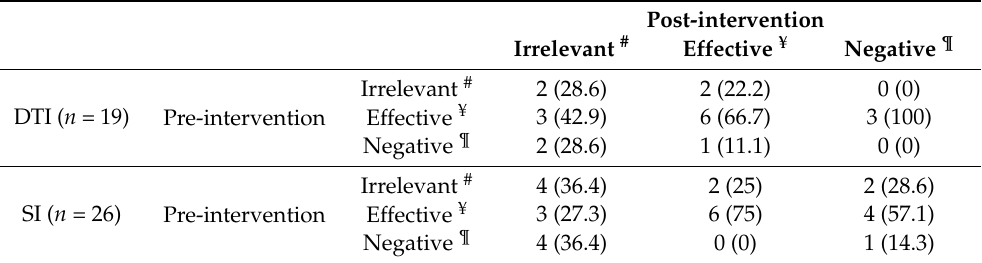
Table 4. Within-subject comparisons on cortisol levels by groups at pre- and post-intervention.